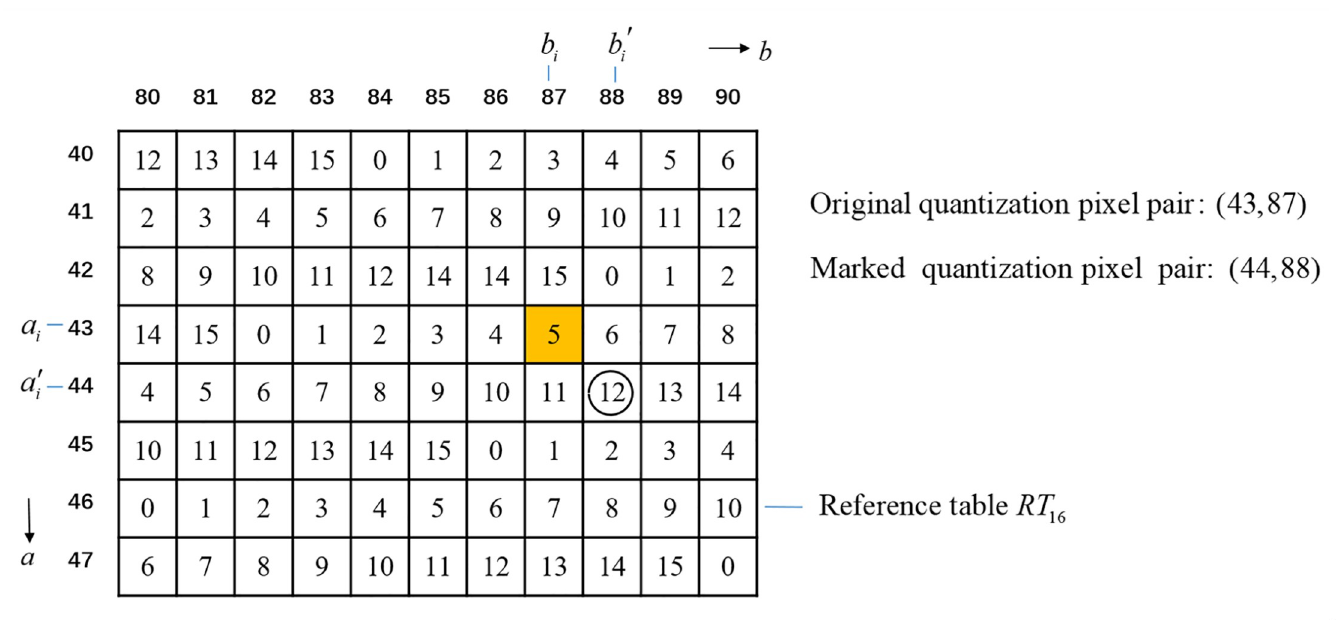
Fig 3. Example of the authentication code embedment.